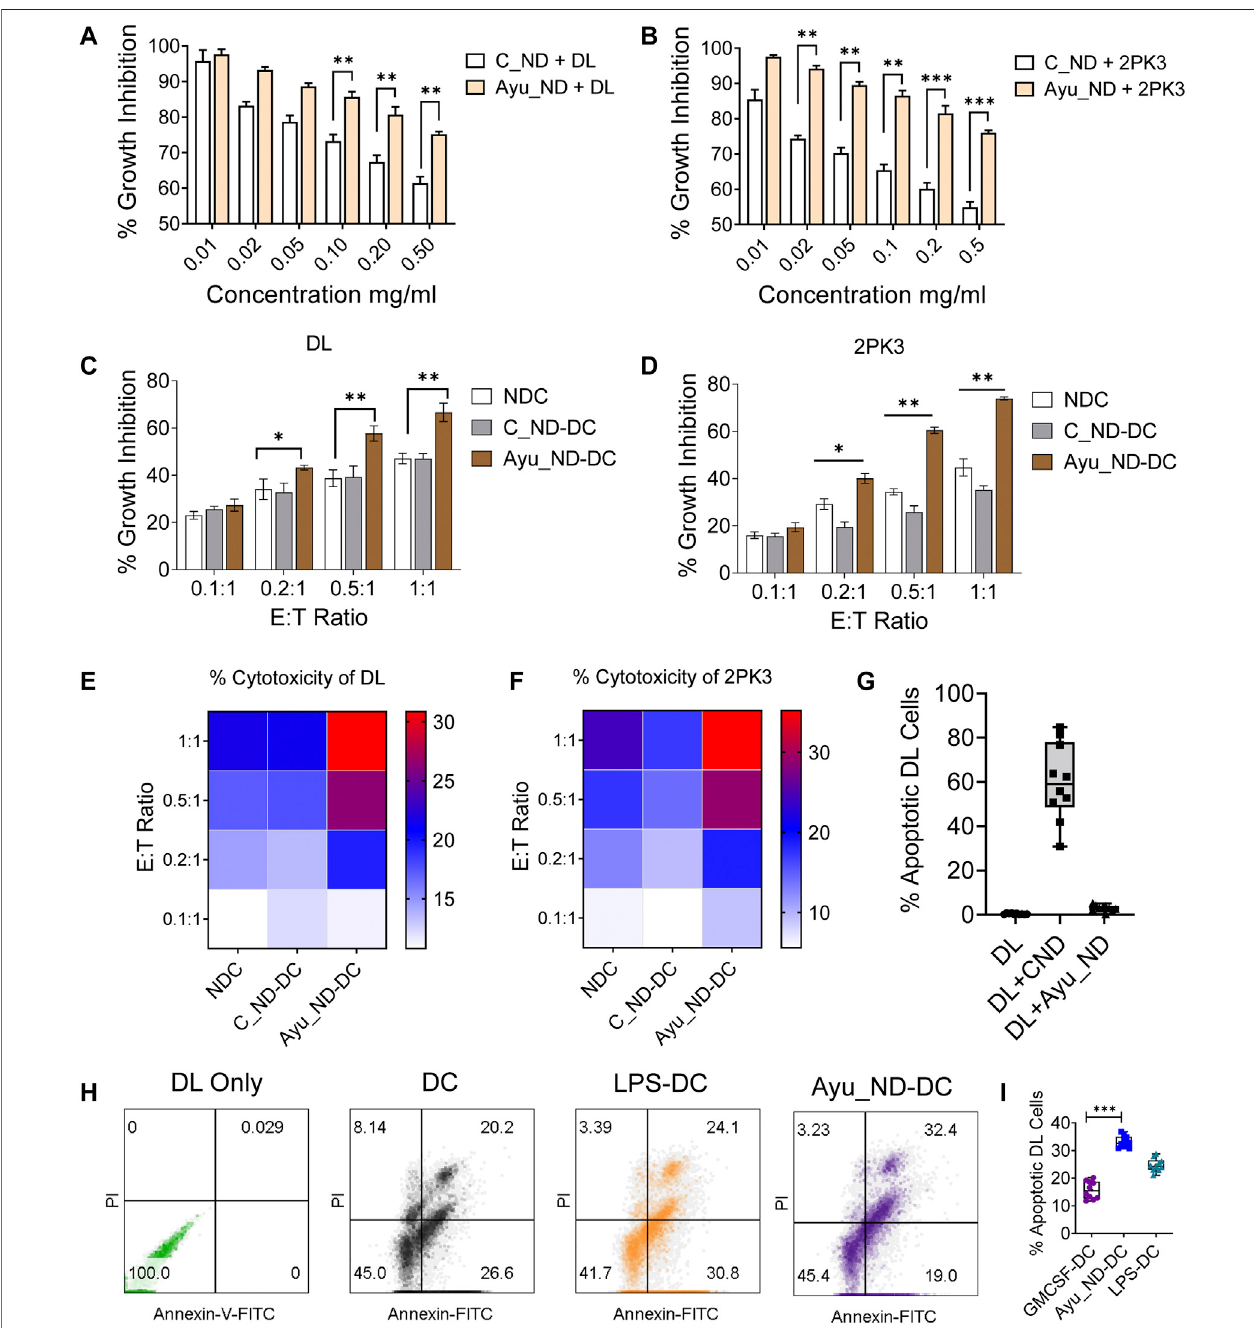
FIGURE3| Ayu_NDaugmentedDC-mediatedantitumoreffectsagainstmurinelymphoma.Ayu_NDaloneistolerantagainstDLand2PK3murinelymphomacells. DL (A) and 2PK3 (B) cells were treated with different concentrations of C_ND or Ayu_ND for 48 h, and growth inhibition was assessed by using the MTT assay. The results are presented as the mean ± SD, n = 4. Naïve, C_ND or Ayu_ND in the presence of naïve or activated splenic DCs were cocultured with lymphoma cells (DL) (C) and 2PK3 (D) at different E:T ratios for 48 h followed by MTT assay. An 18 h cytotoxicity assay was performed using naïve and activated DCs against DL (E) and 2PK3 (F) by LDH release assay. The heatmap color scale indicates the relative enhancement of cytotoxicity ( n = 3). Apoptosis in DL cells following culture with Ayu_ND and CNDs (G) or Ayu_ND-activated DCs (H) was analyzed by FACS following staining with Annexin FITC and PI. % Apoptotic DL cells were documented by fl ow cytometeranalysis (I) .Signi fi cancewasdeterminedbyanunpairedWilcoxontestwithBenjaminiandHochbergcorrection:* p < 0.05,** p < 0.01,*** p < 0.001,and**** p < 0.0001, n = 6.